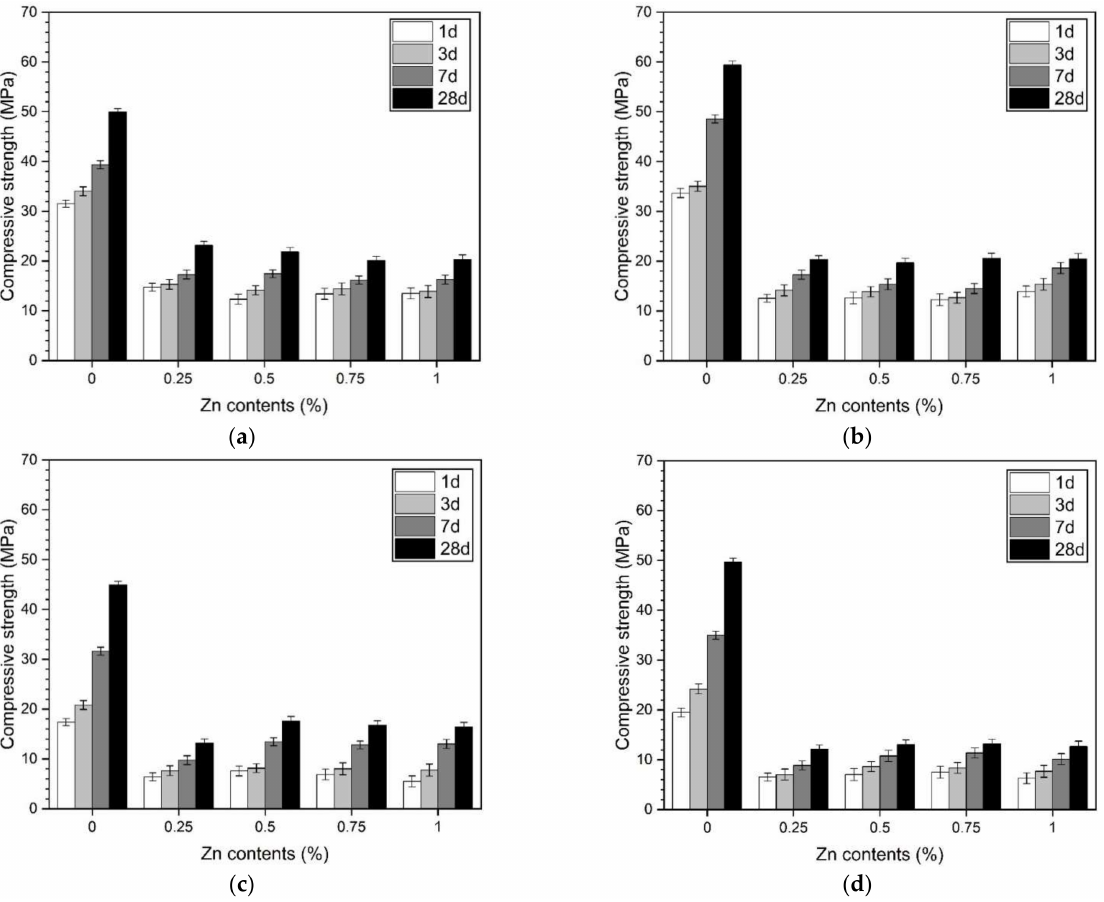
Figure 1. Compressive strength of samples with ( a ) w/b of 0.35, cured at 23 ± 2 ◦ C, ( b ) w/b of 0.35, cured at 40 ± 2 ◦ C, ( c ) w/b of 0.45, cured at 23 ± 2 ◦ C, and ( d ) w/b of 0.45, cured at 40 ± 2 ◦